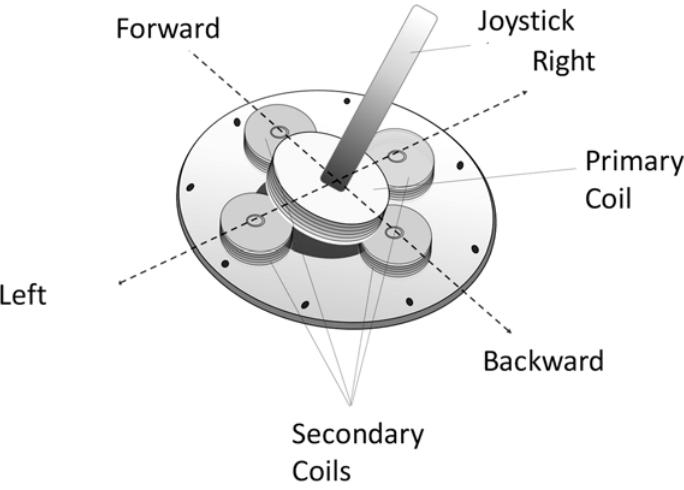
Figure 12. Working principle of existing joystick controller.